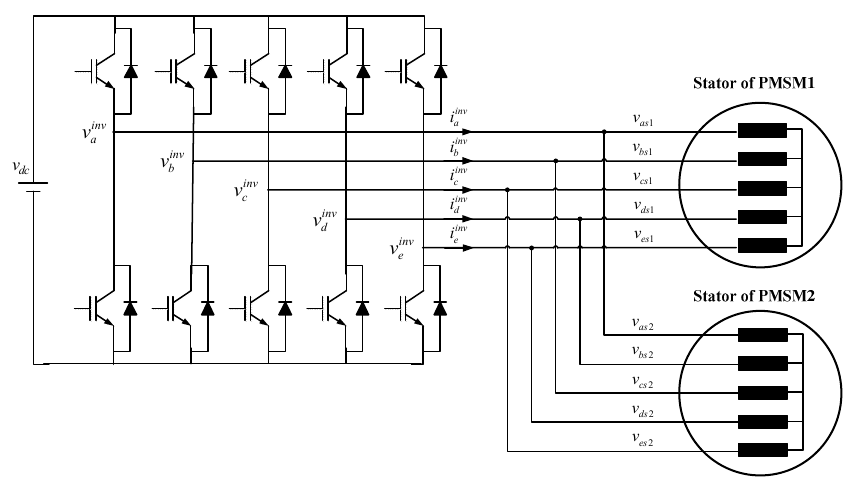
Figure 1. A parallel connected five-phase two-motor drive.